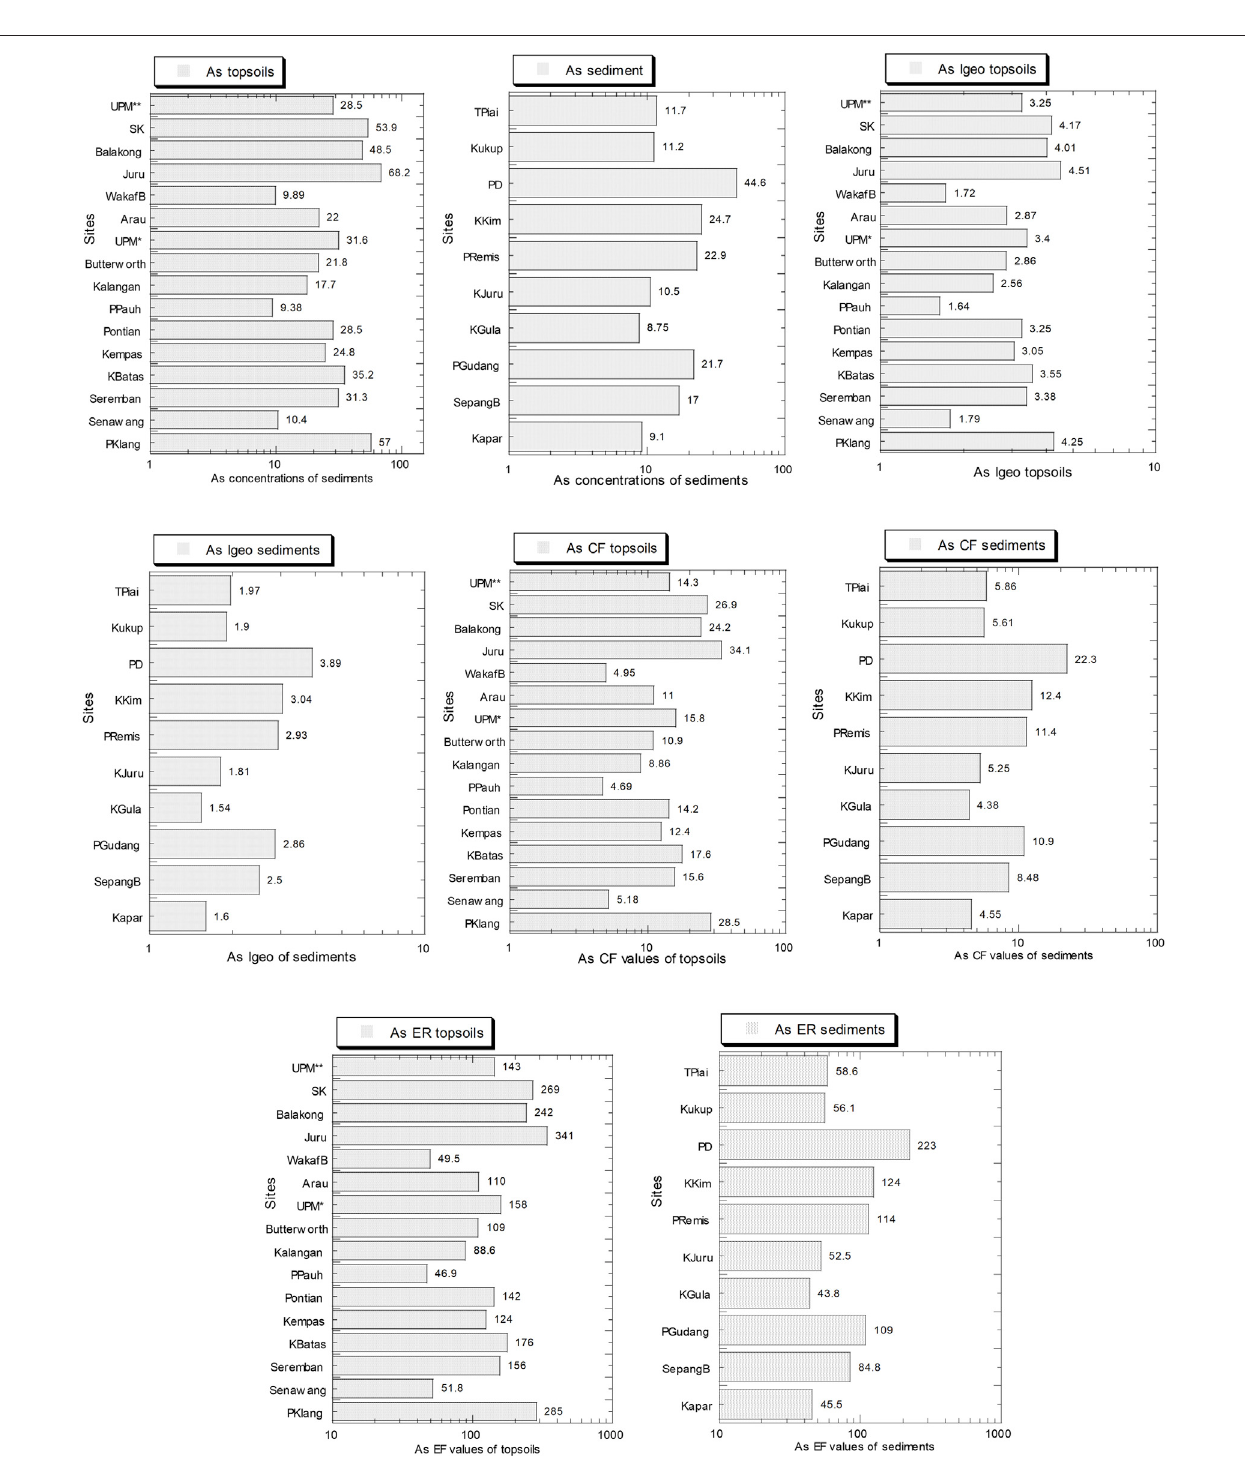
FIGURE8| Geoaccumulationindex(I geo ),contamination factor(CF),and potentialecologicalriskindex(ER) forAsinthetopsoils(numbersinwhitecircles(1 – 16)in Figure 1 ; S1 – S16 in Supplementary Table S1 ) and mangrove sediments (numbers in black circles (1 – 10) in Figure 1 ; M1 – M10 in Supplementary Table S1 ) from Peninsular Malaysia. The X -axes are based on a logarithmic scale.